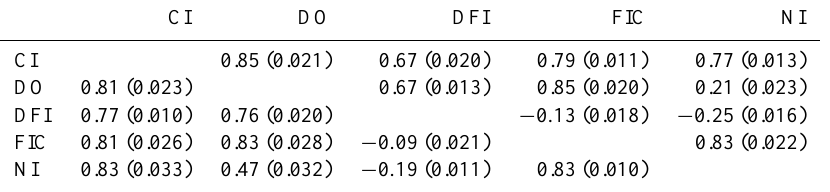
Table 4. Genetic (above diagonal) and permanent (below diagonal) correlations among fertility traits with standard errors in